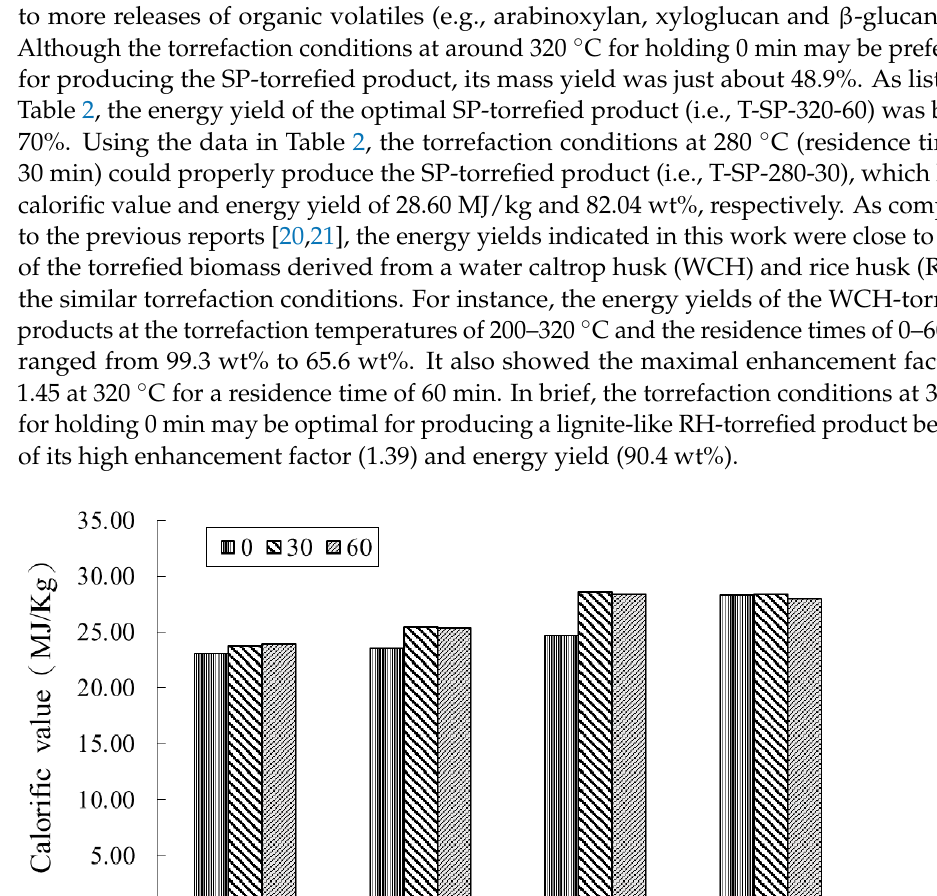
Table 2. Mass yields and calorific values of SP-torrefied products (T-SP) as a function of the temperature (200–360 °C) and residence time (0–60 min).